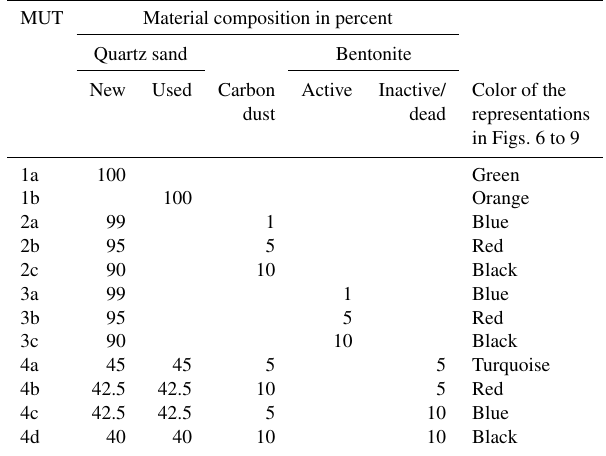
Table 1. Composition of the used-sand mixtures (material under test, MUT). MUT 1a and 1b serve as target values. These mixtures were measured with the measuring cell from Fig. 5a.